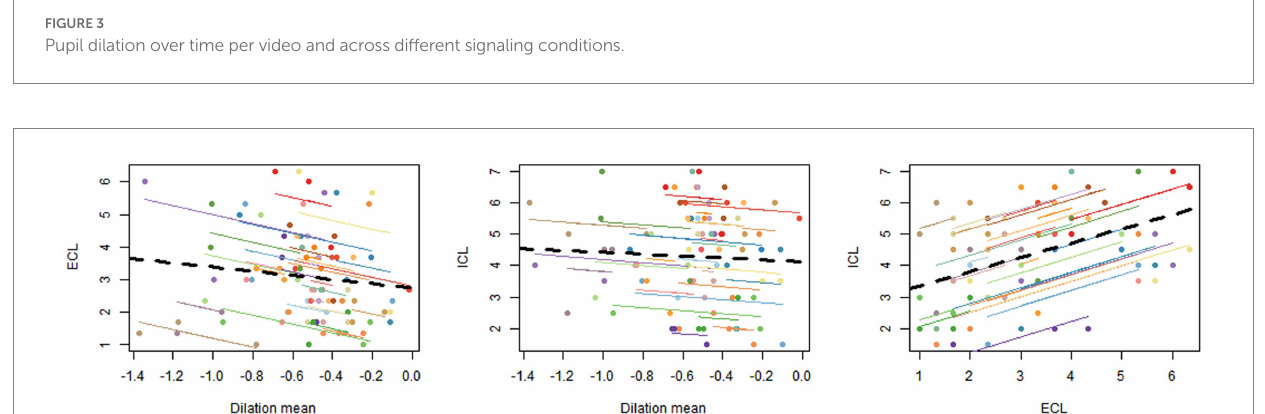
FIGURE 4 Repeated measures correlation plots for the association between pupil dilation and extraneous cognitive load (ECL; Left) and intrinsic cognitive load (ICL; Center), respectively, as well as between ECL and ICL (Right). Each participant provides three data points (one per video) that are shown in a different color. The colored lines show repeated measurement correlation fits for each participant. The black line indicates the overall regression